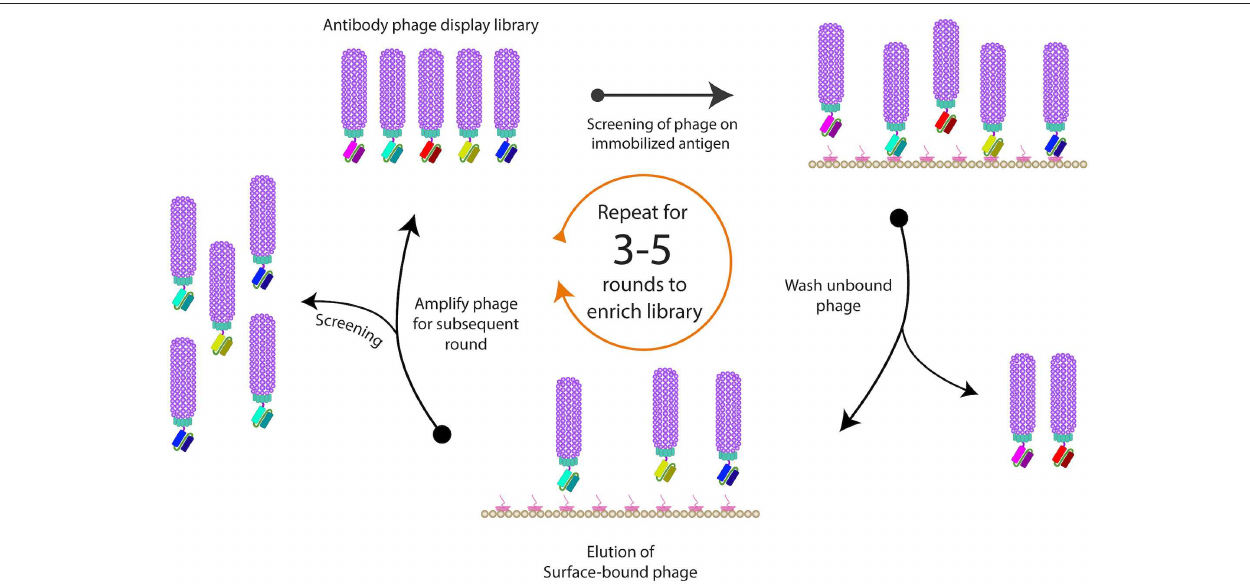
FIGURE 3 | Schematic representation of phage biopanning. This is the basic method for sequential affinity screening of the phage display libraries for specific binding phage from a large excess of non-binding clones is often referred to as “panning or biopanning.” The phage antibody selection involves the immobilization of the ligand of interest on a solid support, followed by applying the phage display library (in the form of purified virions) to the immobilized ligand to allow binding of specific variants. To eliminate the adherent non-binders, multiple rounds of washing are usually performed, and remaining bound phages are eluted and re-amplified. At least three rounds of biopanning are usually required in order to amplify the binding variants and to exclude any non-specific